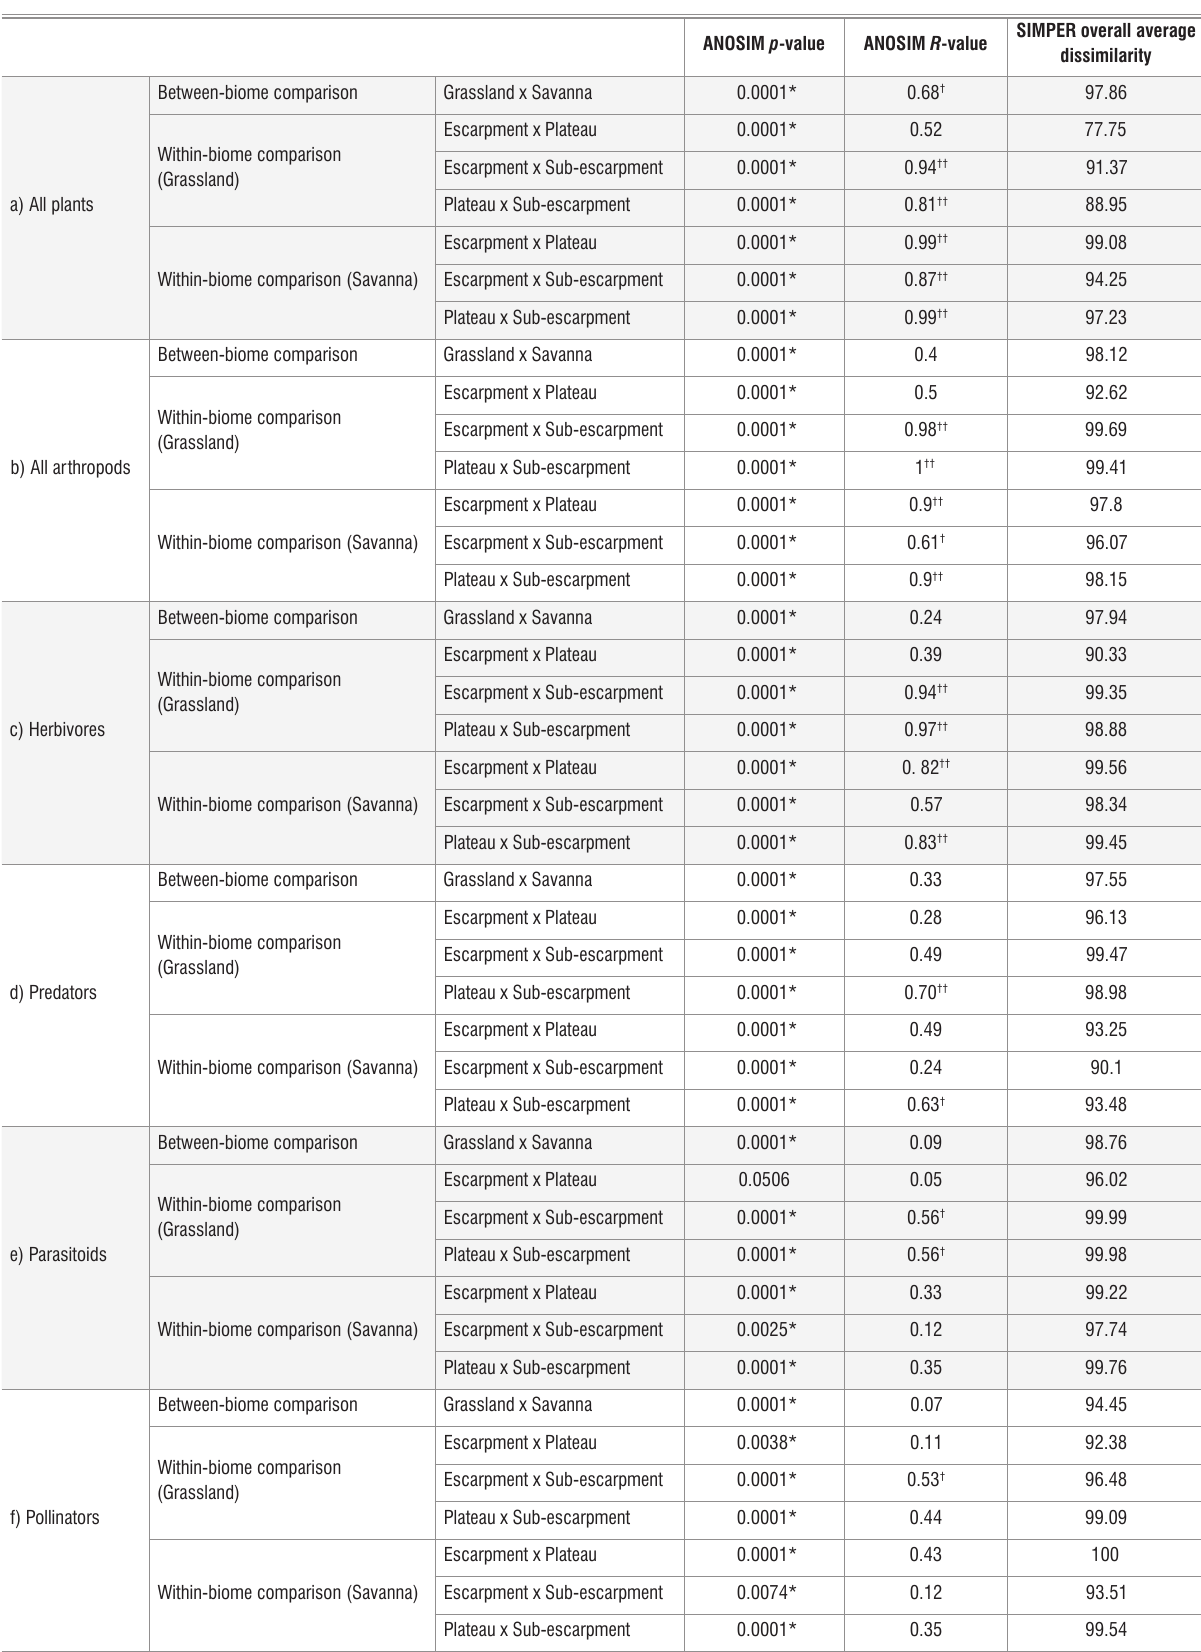
Table 3: Results for ANOSIM and SIMPER analyses for biomes and topographic regions in terms of species composition